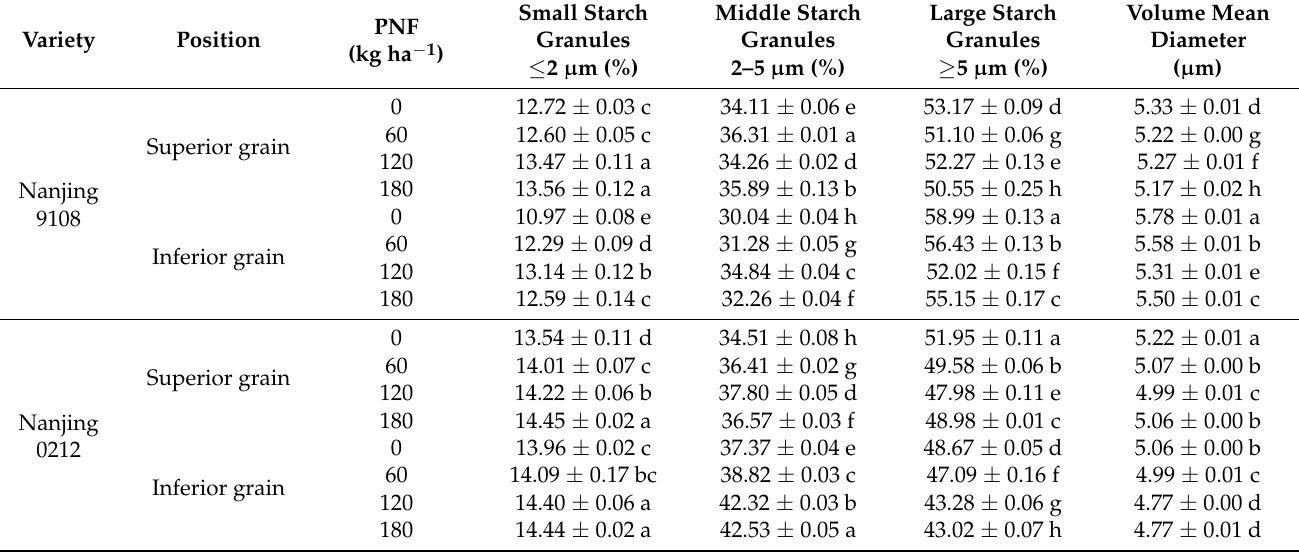
Table 3. Starch granule size distributions of superior and inferior grains of japonica rice under dif- ferent PNF treatments.